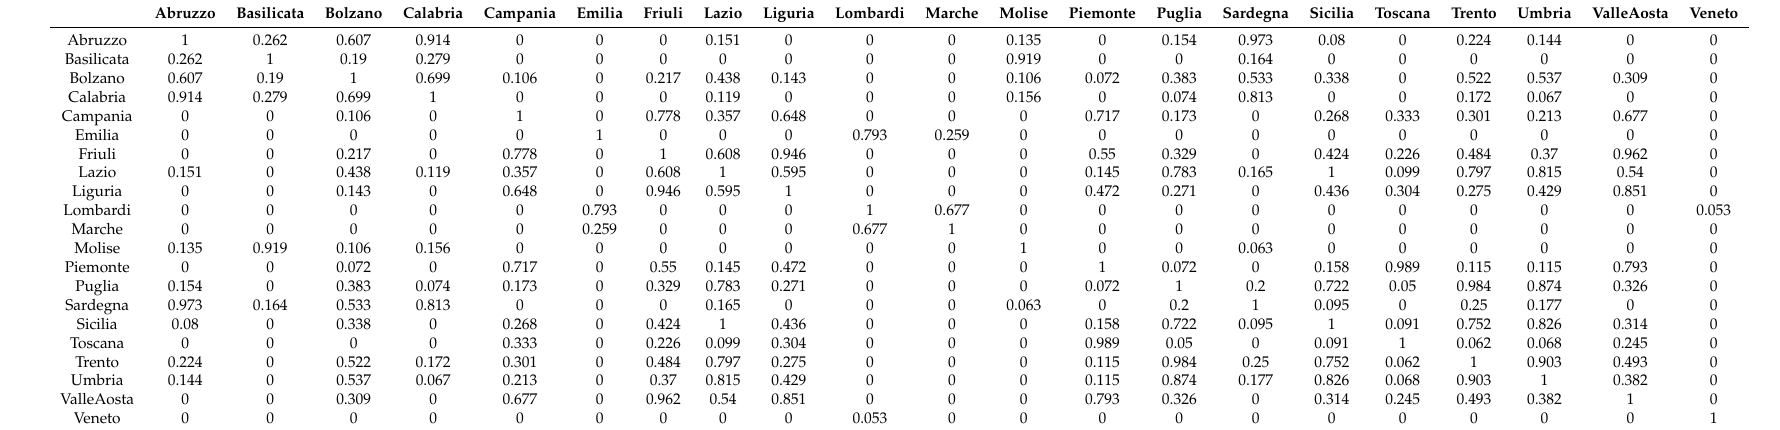
Table A19. Similarity values of Home Isolation network in the study period.